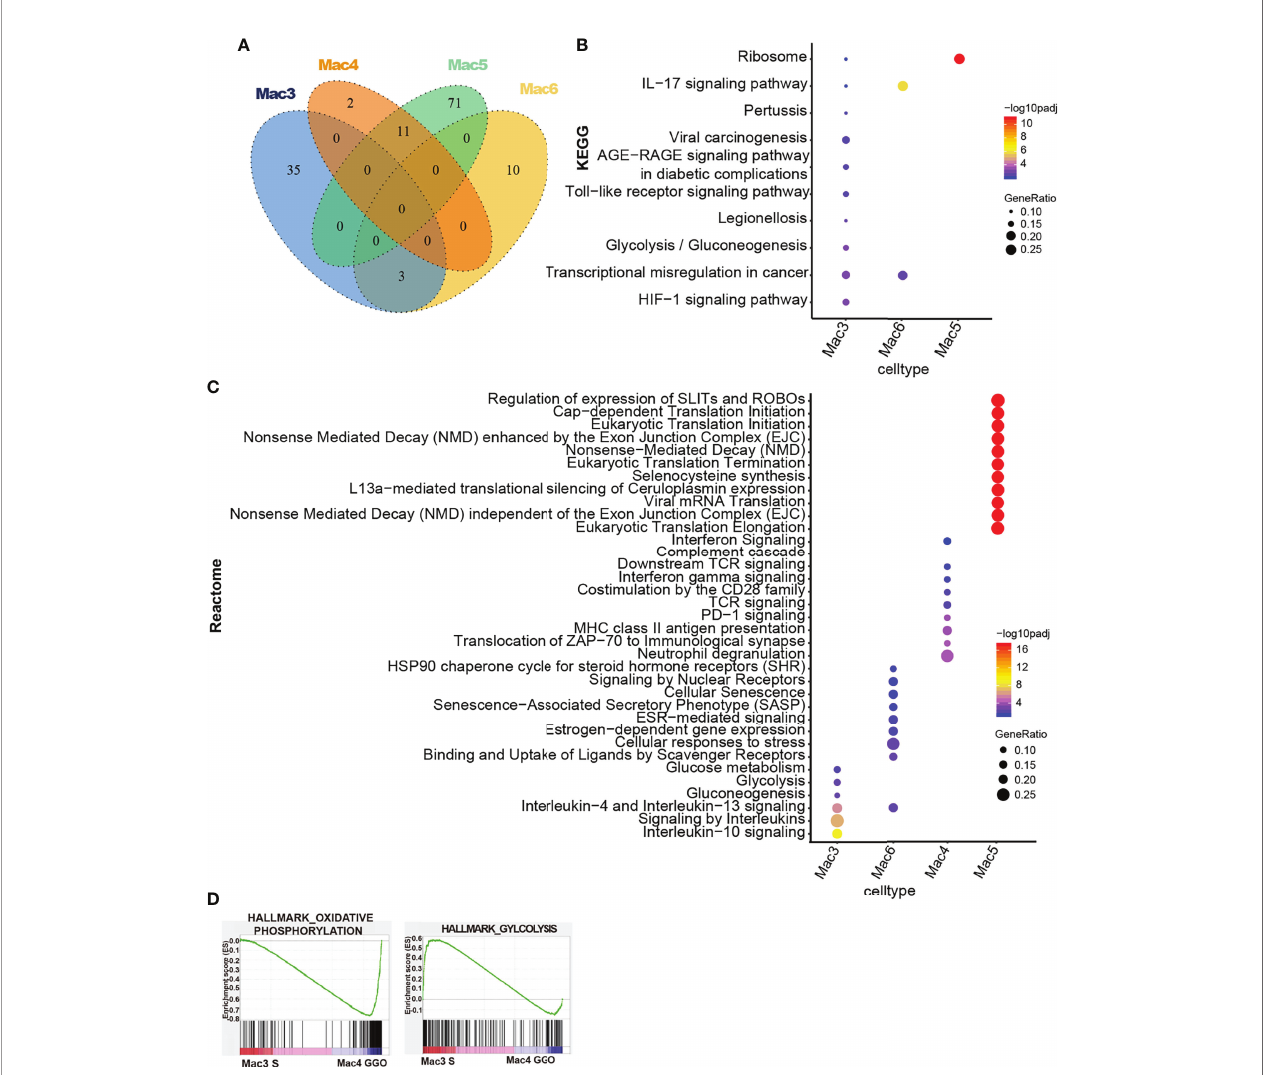
FIGURE 5 | Pathway enrichment of S/GG component-dominant macrophage subclusters. (A) The Venn diagram shows overlapping signi fi cantly upregulated pathways in Mac3, Mac6, Mac4, and Mac5, (B, C) The bubble plot shows signi fi cantly enriched KEGG and Reactome pathways in Mac3, Mac6, Mac4, and Mac5. The colors of bubbles represent the values of signi fi cance, and the sizes represent the number of genes enriched in the pathway. (D) The GSEA using pre-ranked differentially expressed genes between Mac3 _S component versus Mac4 _GG component were compared with hallmark gene sets. The pre-ranked gene set was de fi ned by function of the FindMarkers in Seurat. The enrichment of the oxidative phosphorylation pathway and glycolysis pathway is shown on the graph. S, solid; GG, ground glass; KEGG, Kyoto Encyclopedia of Genes and Genomes; GSEA, gene set enrichment